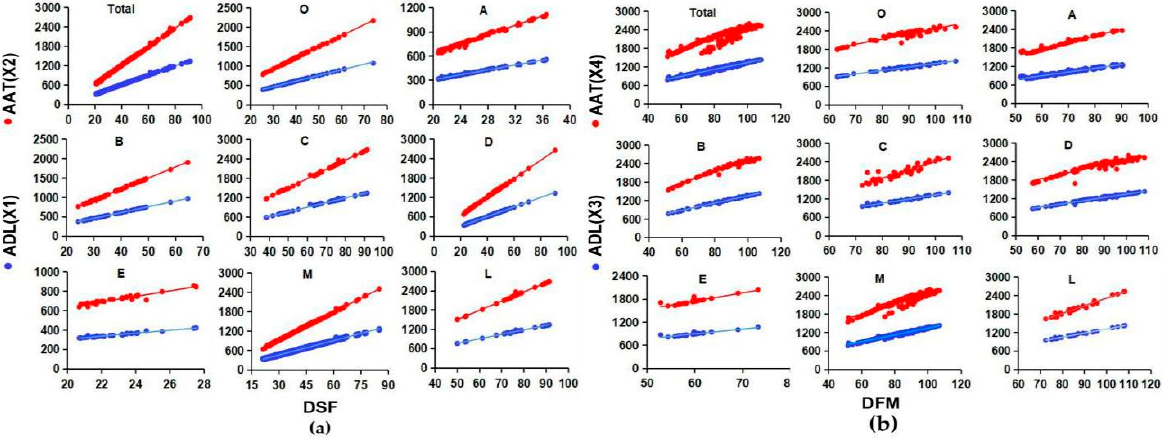
Figure 1. ( a ) Scatter plots of ADL DSF (blue) and AAT DSF (red) for DSF of geographic subpopulations and MG subpopulations in WSGP. ( b ) Scatter plots of ADL DFM (blue) and AAT DFM (red) for DFM of geographic subpopulations and MG subpopulations in WSGP. “Total” represents the total 354 varieties in WSGP. “O” represents the varieties from the center of origin in both Huang-Huai River Valleys (HCHN) and Chang-jiang River Valleys and its south (SCHN). “A” represents the varieties from Northeast China (NCHN), Far-East Russia (RUFE) and southern Sweden (SSWE); “B” represents the varieties from the Korean peninsula (KORP) and Japan islands (JPAN); “C” represents the varieties from Southeast Asia (SEAS), South Asia (SASI) and Africa (AFRI); “D” represents the varieties from northern North America (NNAM), southern North America (SNAM) and Central and South America (CSAM). “E” represents the early MG ‐ set varieties (MG 000~0); “P” represents the primary MG ‐ set varieties (MG I~VII); “L” represents the late MG ‐ set varieties (MG VIII~X). The same is true for the latter figure.